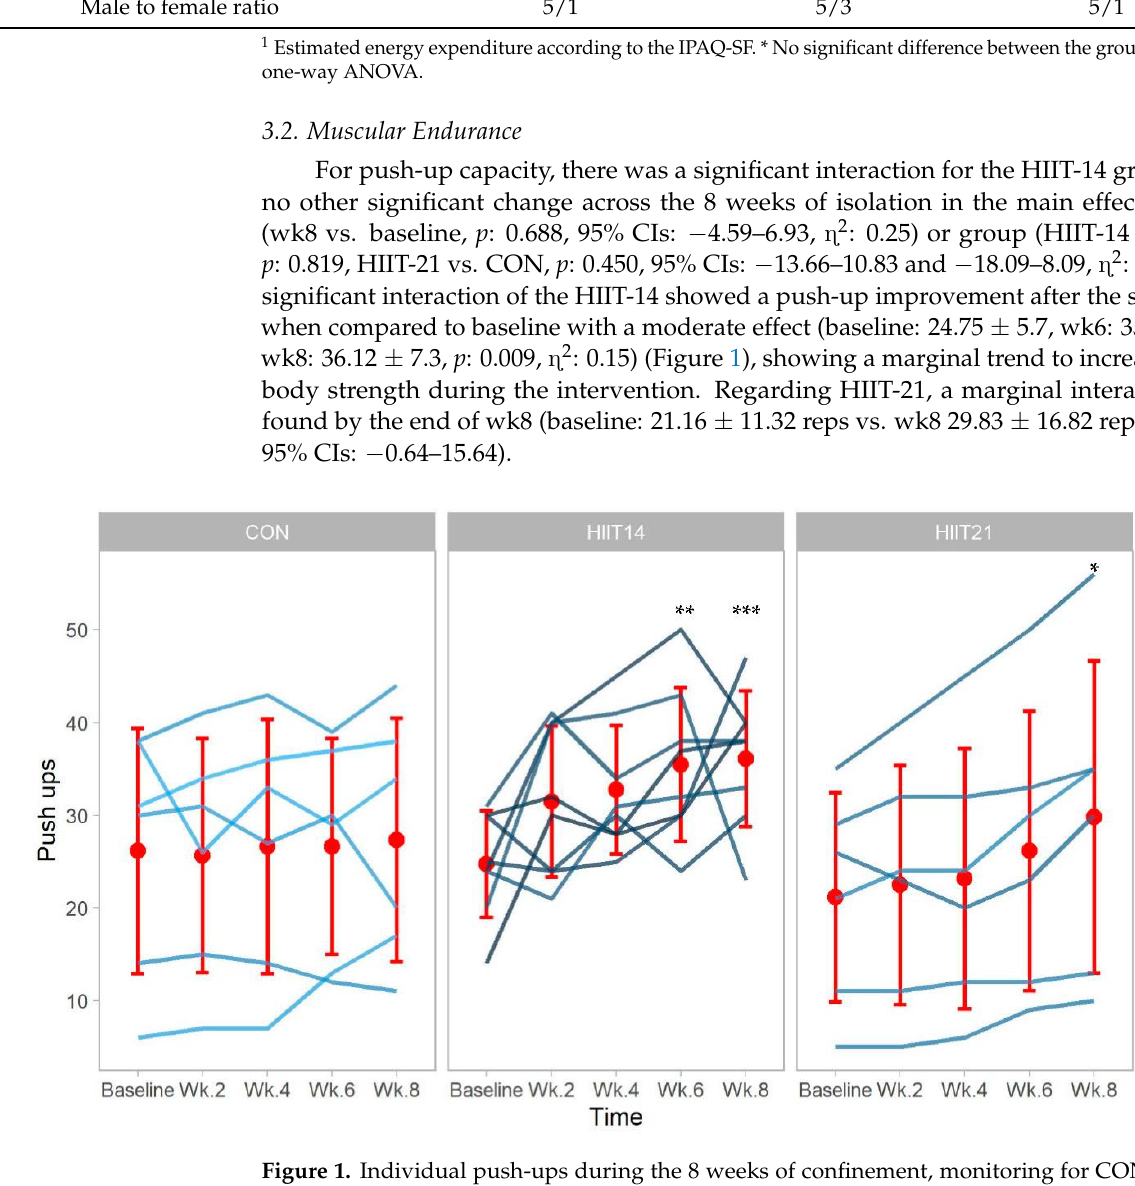
Figure 1. Individual push-ups during the 8 weeks of confinement, monitoring for CON (control), HIIT-14 (14), and HIIT-21 (21). *** ( p < 0.001 vs. baseline), ** ( p < 0.01 vs. baseline), and * ( p < 0.05 vs. baseline). Red dots: Mean values of every week; red bracket lines: standard deviations of the time measure.